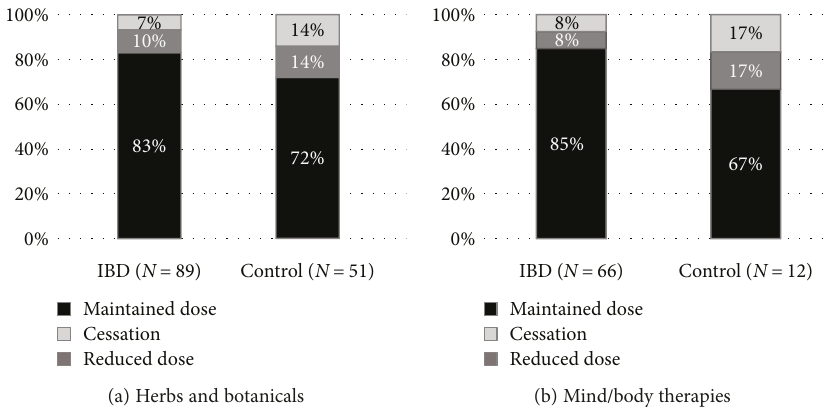
Figure 4: Continuation rates of conventional medication among patients using (a) herbs and botanicals and (b) mind/body therapies. IBD: in fl ammatory bowel diseases.